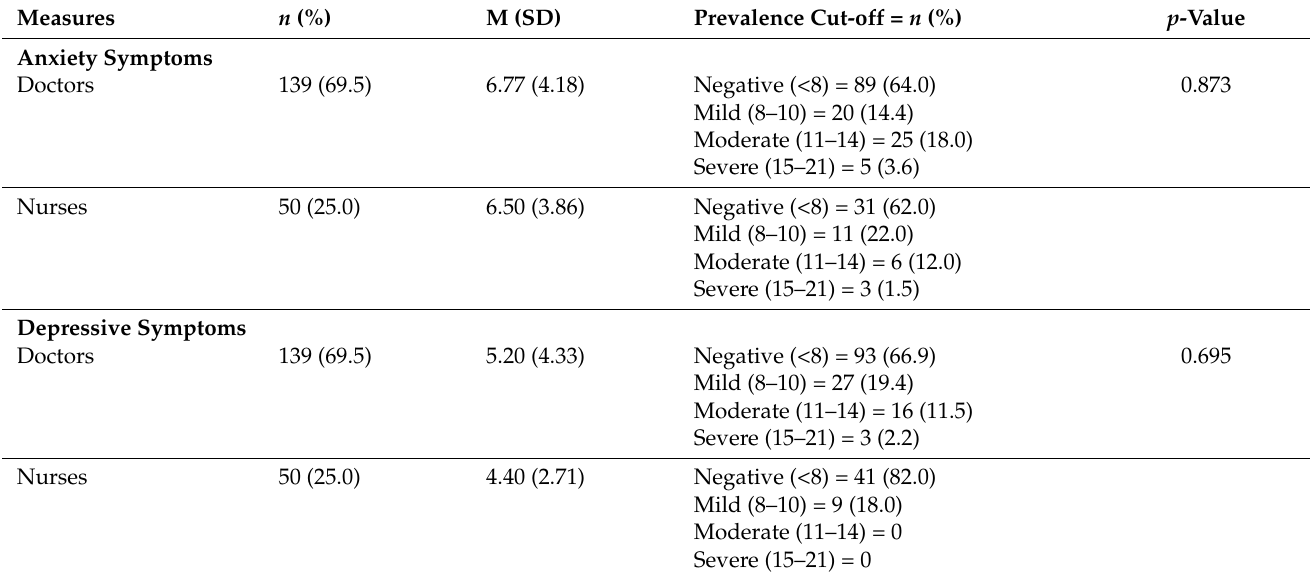
Table 5. Scores and cut-offs of anxiety and depressive symptoms, doctors versus nurses ( n = 189).